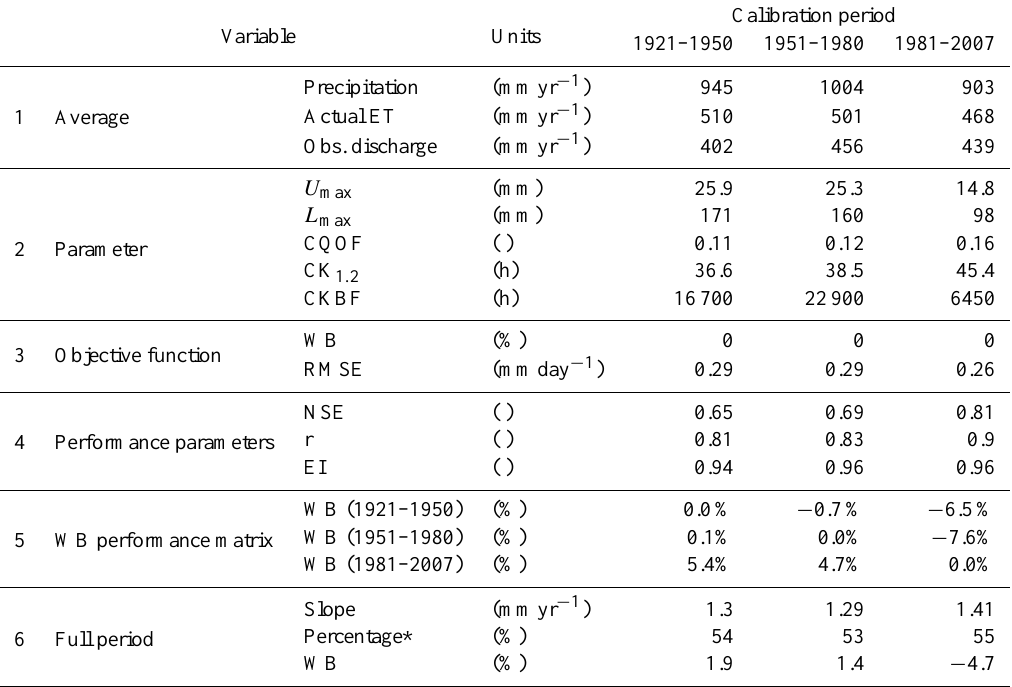
Table 6. Climate variable averages from 30yr periods (1). Model parameters (2), objective function (3), and model performance (4) on each of the 30yr periods (WB – relative water balance; RMSE – root mean square error; NSE – Nash–Sutcliffe coefficient; r – correlation coefficient; EI – error index). Water balance results found when parameter values estimated on the individual 30yr periods (2) are used